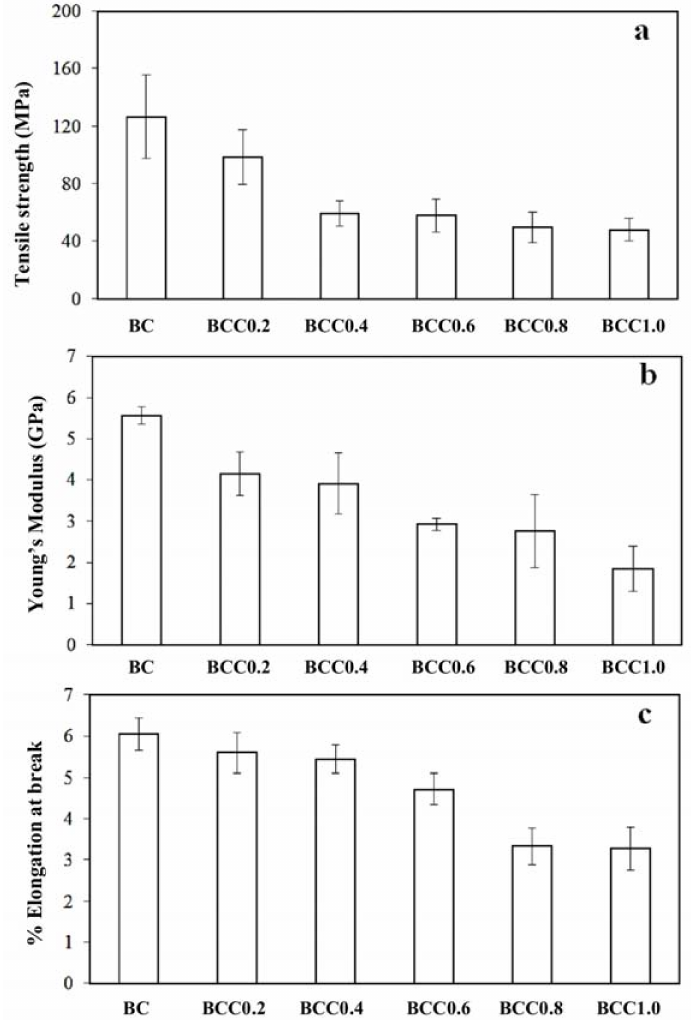
Figure 4. Tensile strength ( a ), Young’s modulus ( b ), and % elongation at break ( c ) of BC and curcumin-loaded BC films. Values were expressed as mean ± SD ( n =